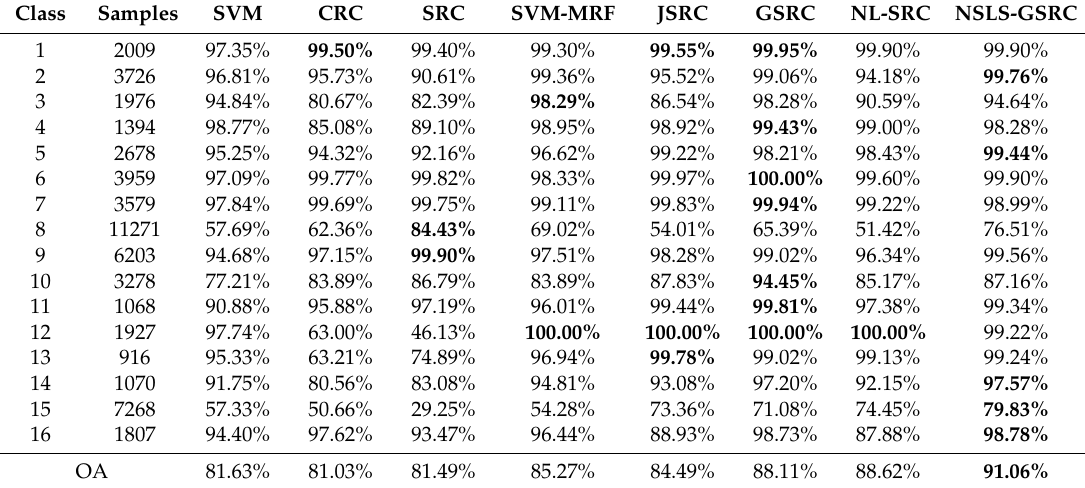
Table 3. Classification accuracies (in percent) obtained by the different tested methods for the AVIRIS Salinas scene. In all cases, 320 labeled samples in total (20 samples per class) were used for training. The best results are in bold.